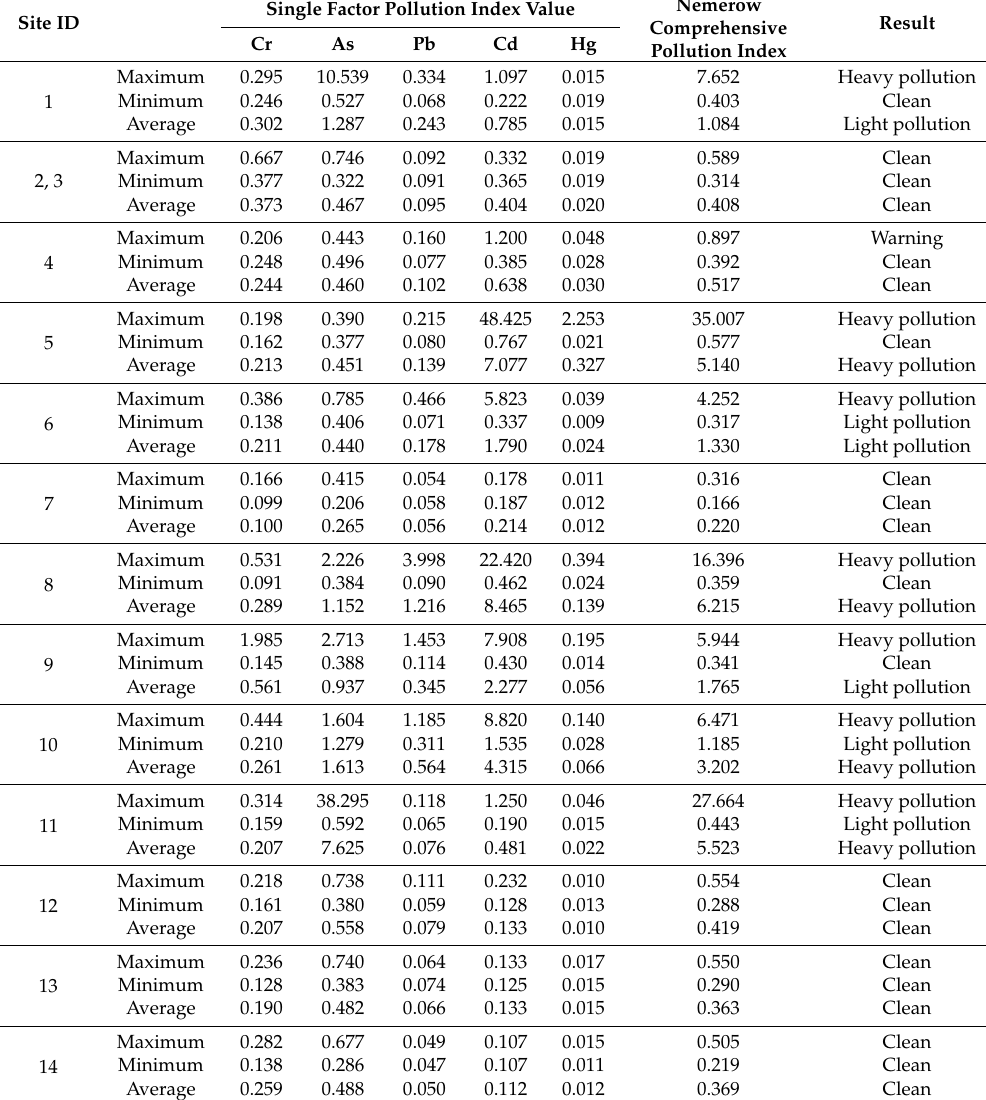
Table 4. Soil arsenic and heavy metal pollution assessment results by pollution index methods. Site